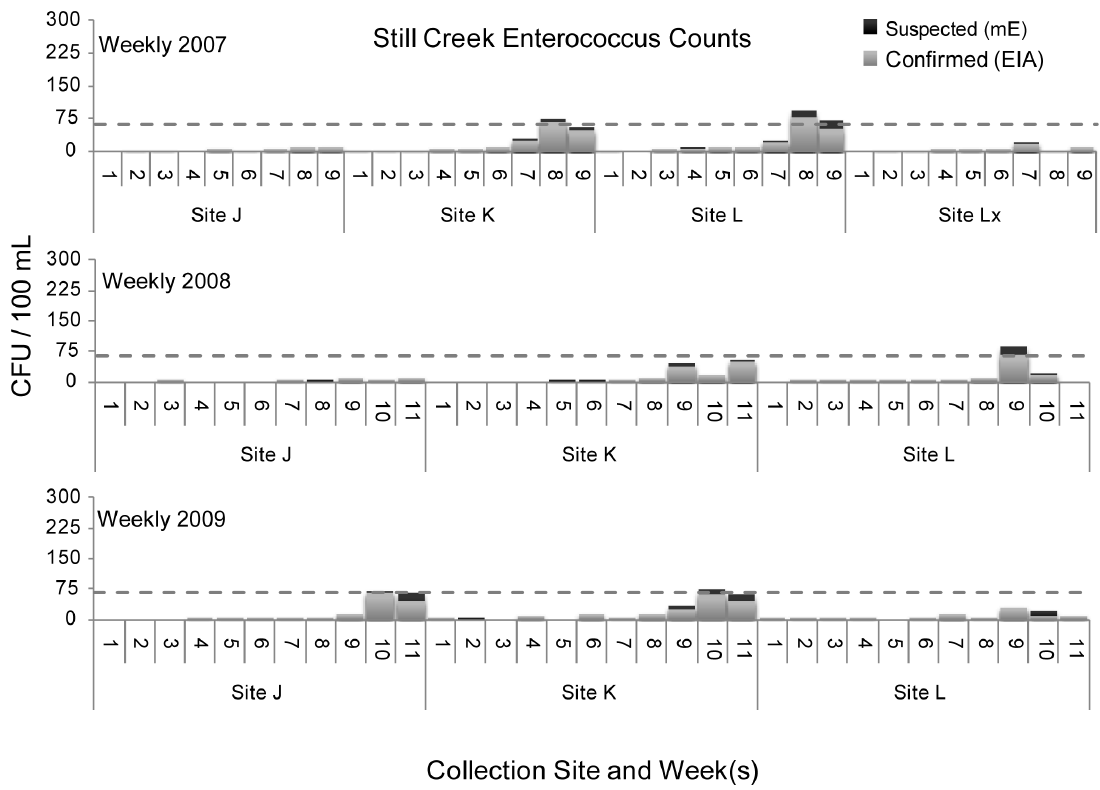
Figure 9. Still Creek Enterococcus counts.